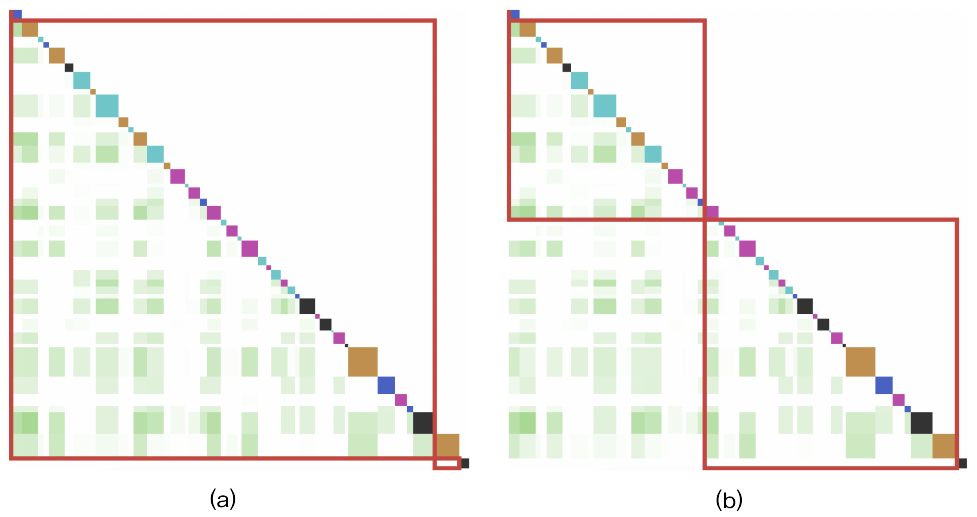
Figure 12. Before ( a ) and after ( b ) self-continuity is applied to conceptual similarities. By applying the weight of the metric that quantifies the self-continuity, the transcript is segmented based on the corresponding conceptual similarities of